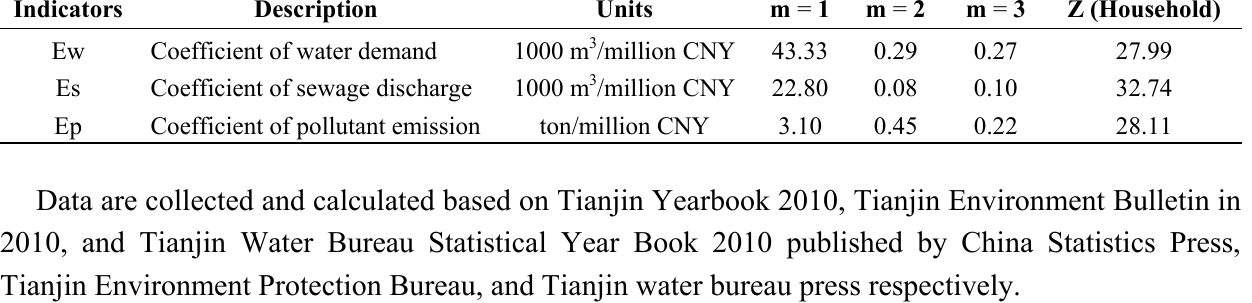
Table 4. Coefficient indicators of water demand, sewage generation and water pollutant emission.